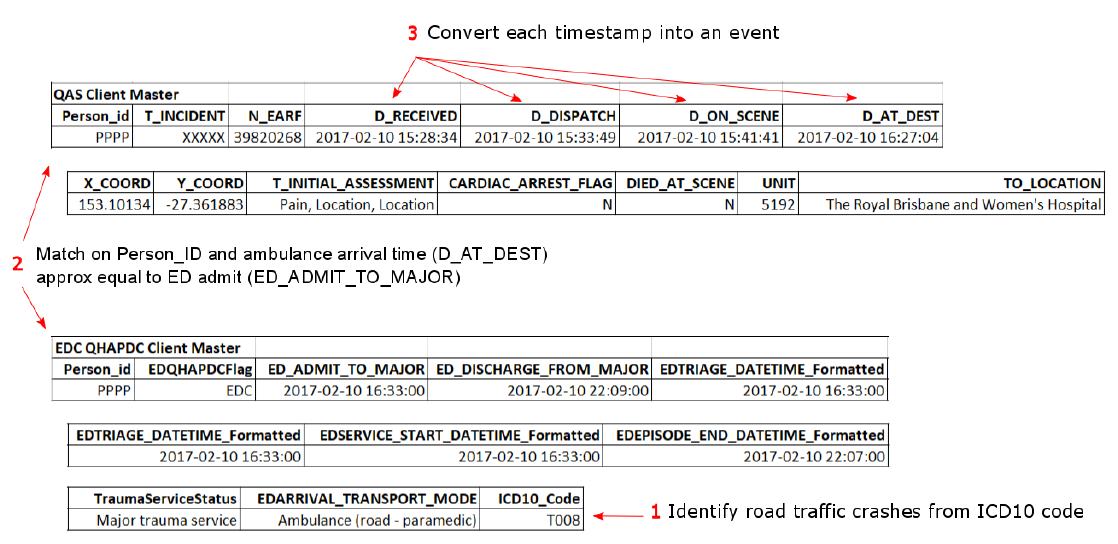
Figure 2. Sample data from Queensland Ambulance Services (QAS) and Emergency Department